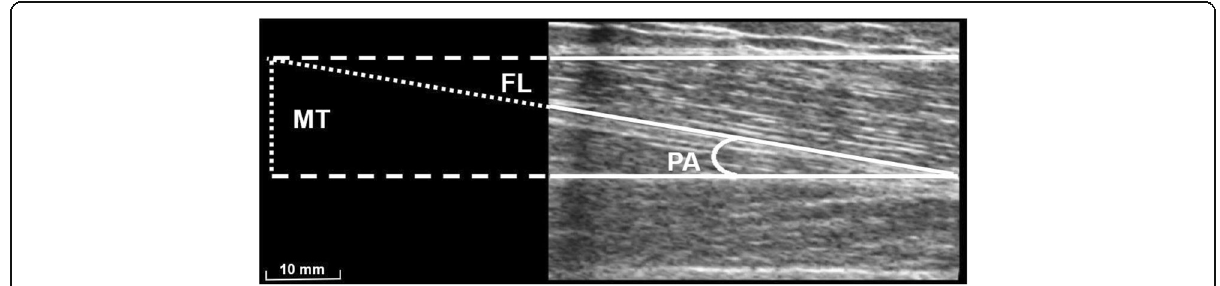
Fig. 1 Ultrasound image showing vastus lateralis muscle architecture parameters: muscle thickness (MT), pennation angle (PA), and estimated fascicle length